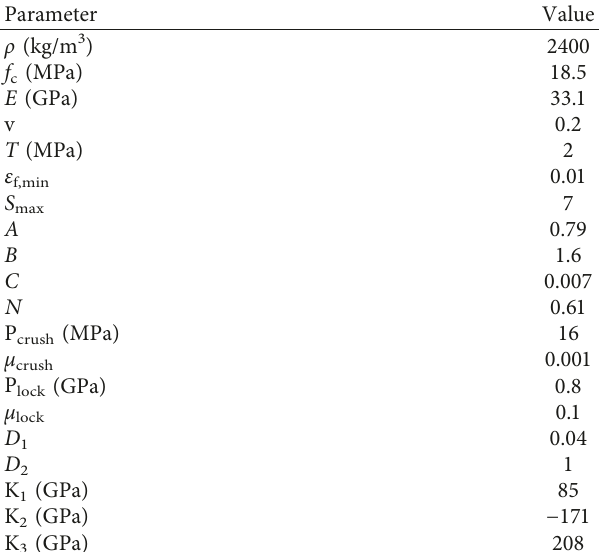
Table 6: Material parameters of the concrete model [14, 25].